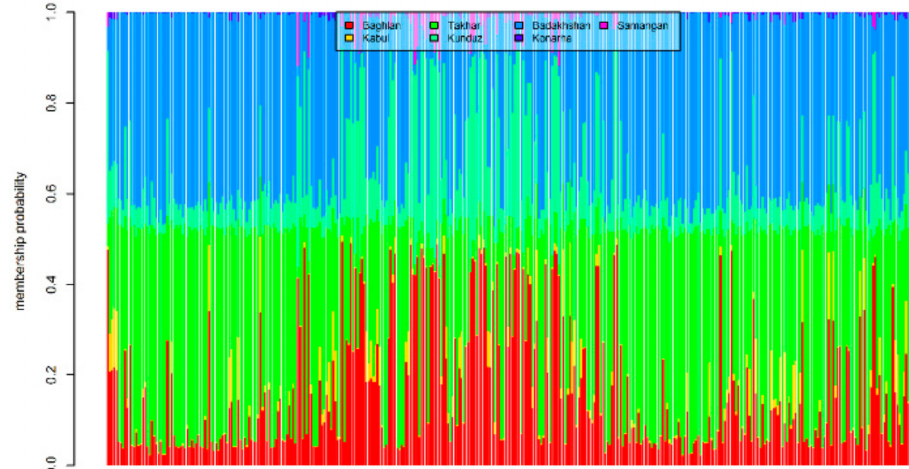
Figure 8. Estimated population membership probability of 363 bread wheat landraces from seven states of Afghanistan, where each bar represents a